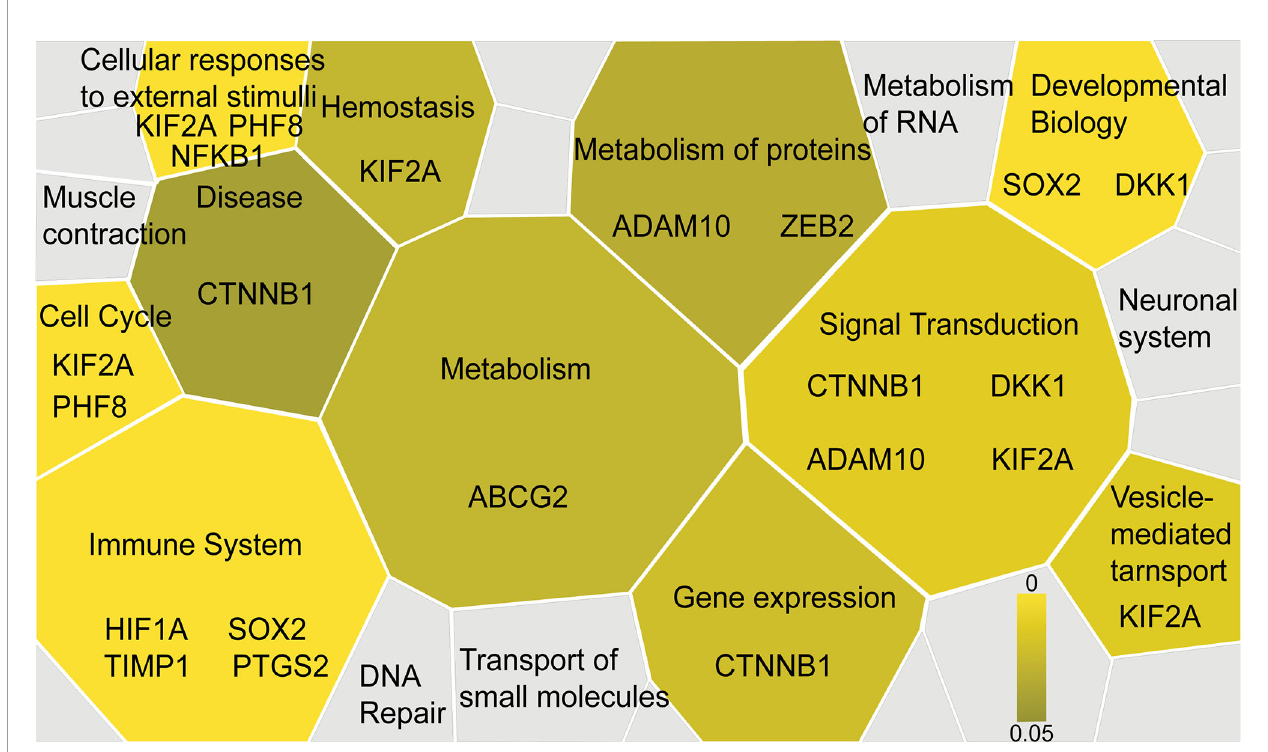
FIGURE 3 | Functional signi fi cance of the selected IHC biomarkers identi fi ed by the systematic review and meta-analysis. Functional signi fi cance of the identi fi ed IHC biomarkers is visualized by using the Reactome pathway database (https://reactome.org), reporting on biological pathways associated with dataset of genes. The results are visualized as a Voronoi diagram, showing an overview of the biological pathways related to the 31 biomarkers identi fi ed by the systematic review and meta-analysis. Signi fi cantly enriched pathways are shown with a color scale from dark to light yellow. IHC biomarkers associated with each pathway are shown.